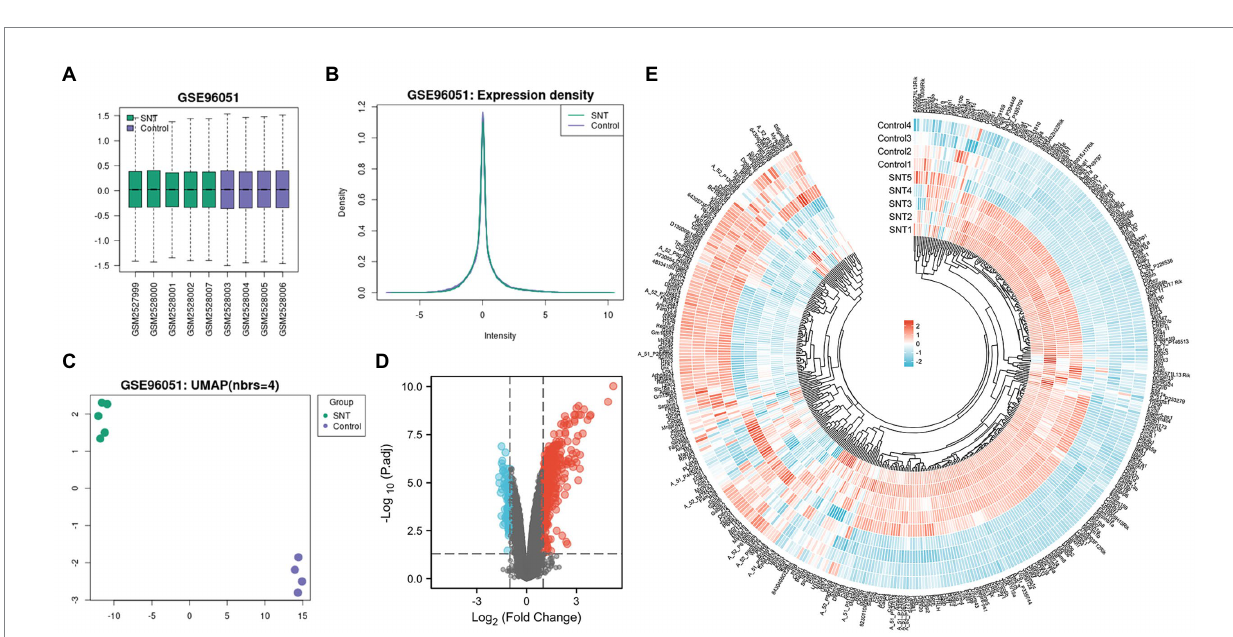
FIGURE 1 Differentially expressed profile of mRNAs and characterization between the SNT group and the control. (A) Boxplot shows the distribution of the values of the DRG samples, abscissa represents sample name and ordinate represents the normalized intensity values, the upper and lower sides of the rectangular box mean minimum and maximum values, the upper and lower lines of the error bars mean interquartile range, the line inside the rectangular box means median value. (B) The density map of GSE96051 shows the expression of each sample. (C) The UMAP shows the distribution relationships between the samples. (D) Volcano plot of DEmRNAs. The vertical lines correspond to twice the fold changes in upregulation or downregulation; the horizontal line represents p -adjusted = 0.05; red points indicate mRNAs with upregulation and blue points indicate mRNAs with downregulation. (E) Hierarchical cluster analysis of DEmRNAs. Blue and red color indicate down-regulation and up-regulation of gene expression,